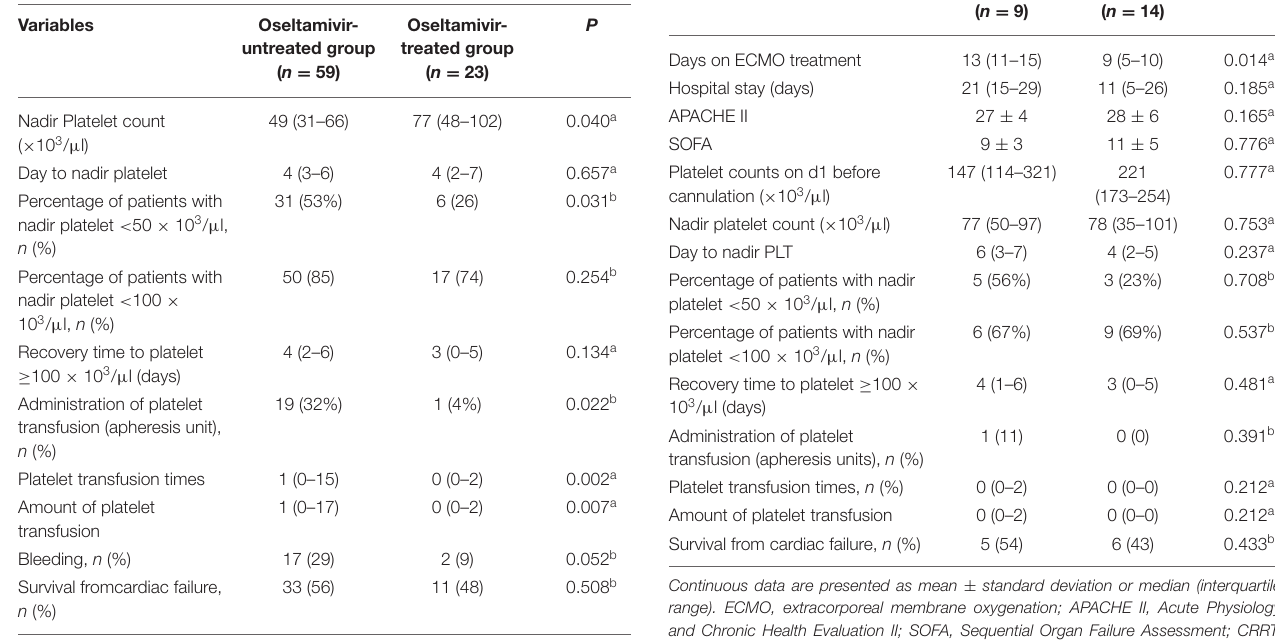
TABLE 2 | Changes in platelet count and treatment outcomes in patients with refractory cardiac failure during the first 8 days of ECMO.